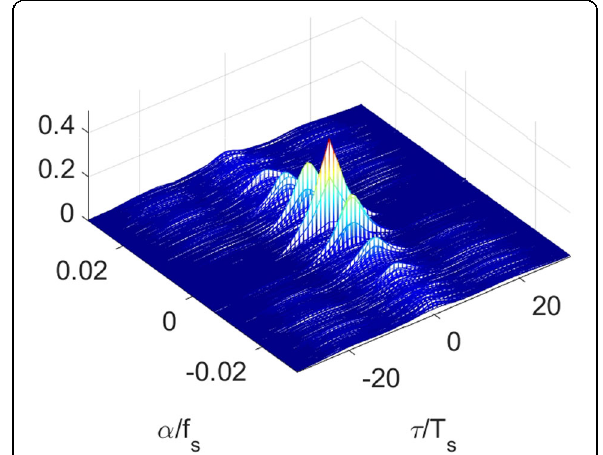
Fig. 7 Case A: magnitude of the cyclic correlogram of the de-warped data, with SNR ¼ 10 dB, as a function of α / f s and τ / T s ð f s ¼ 1 = T s